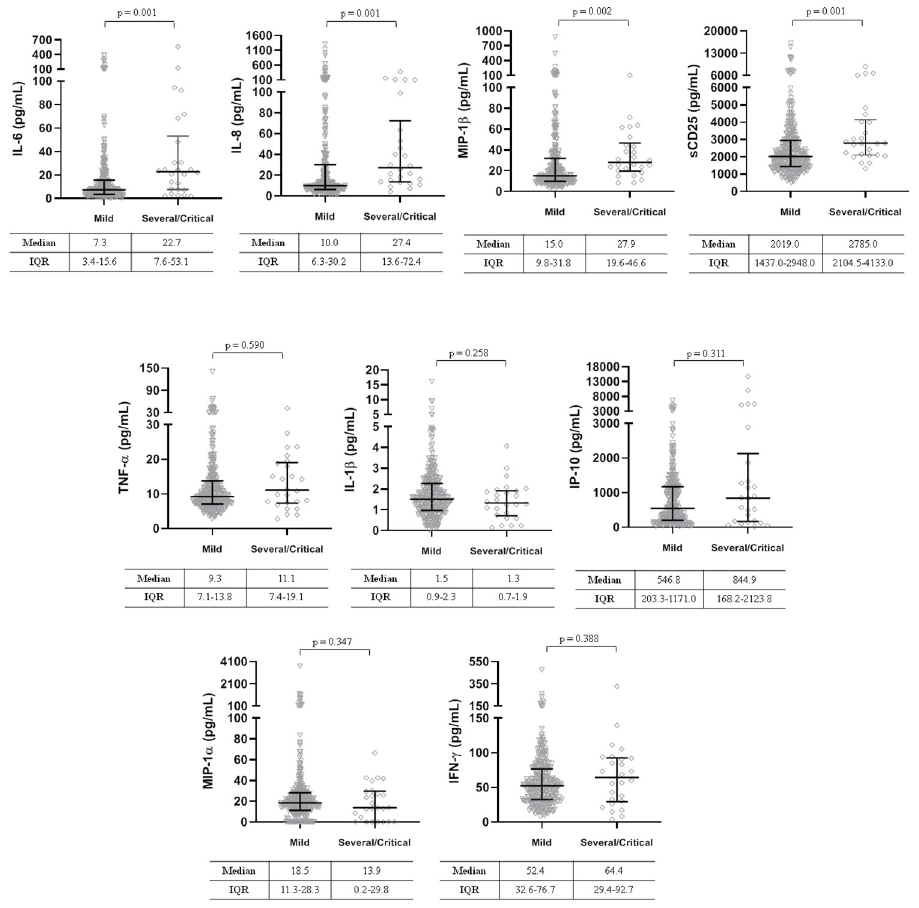
Fig 1. Plasma cytokine concentrations at baseline according to four-point ordinal categories based on oxygen at admission. Mild, oxygen therapy with mask or nasal prongs. Severe/Critical, high-flow oxygen requirement, non- invasive ventilation, mechanical ventilation or extracorporeal membrane oxygenation, and death. IL-6, interleukine-6; IL-8, interleukine-8; MIP-1 β , macrophage inflammatory proteins 1 β ; sCD25, soluble receptor interleukine-2; TNF- α , tumor necrosis factor α ; IL-1 β , interleukine-1 β ; IP-10, interferon γ -induced protein 10; MIP-1 α , macrophage inflammatory proteins 1 α ; IFN- γ ,